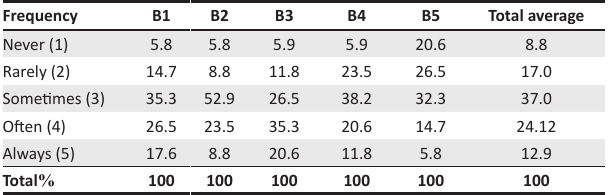
TABLE 2 : Provincial MuniMEC forum efficiency.